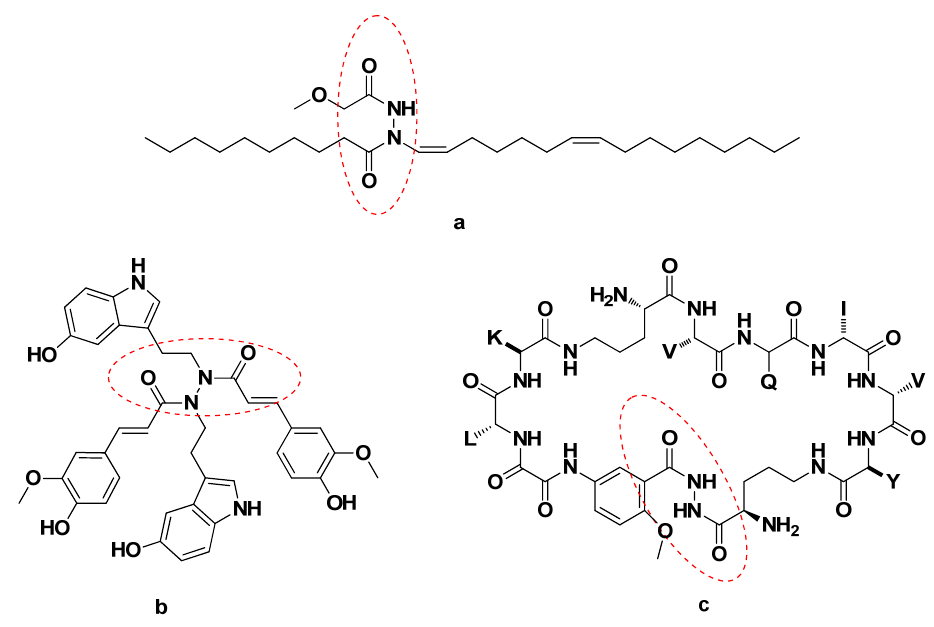
Figure 1. The natural products containing acylhydrazine